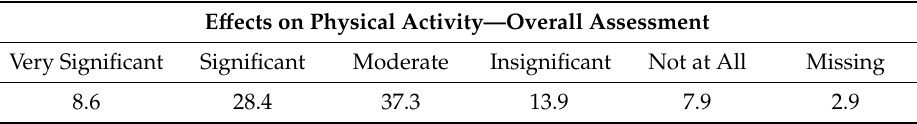
Table 3. Overall assessment of the e ff ects on physical activity after the project. E ff ects on Physical Activity—Overall